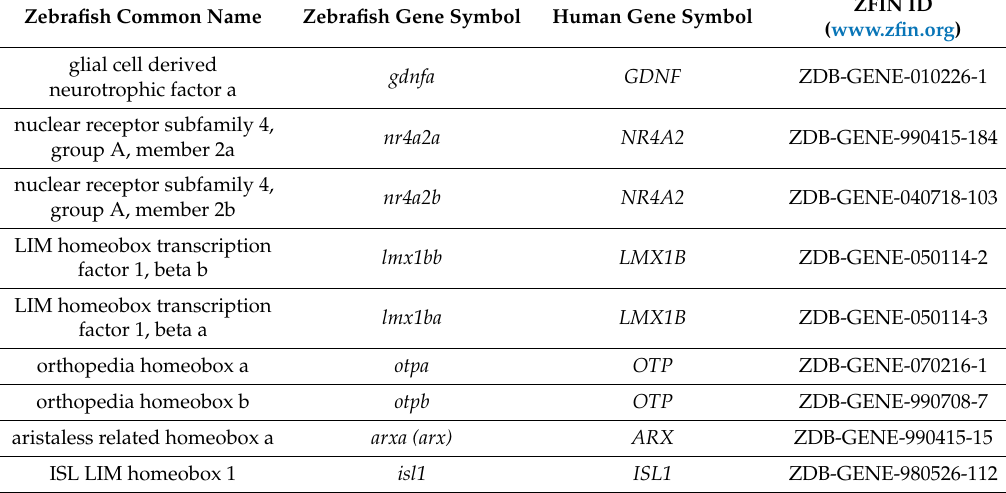
Table 1. Zebrafish genes involved in dopaminergic neuronal